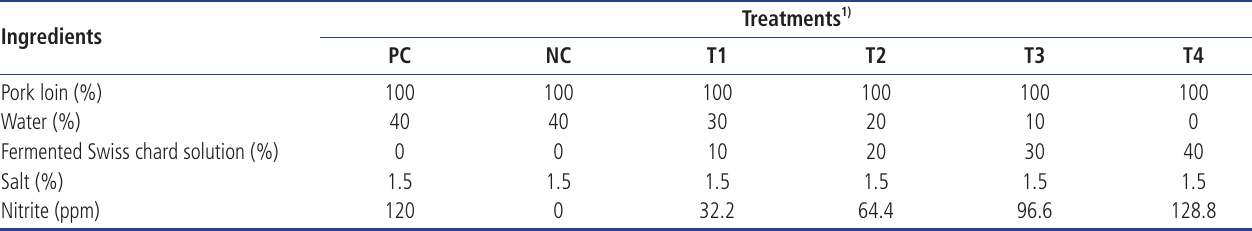
Table 1. Formulation of cured pork loin with natural nitrite source from fermented Swiss chard (FSC)